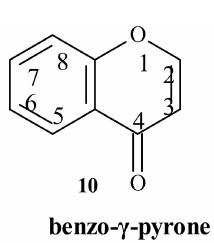
Figure 5. Structure of chromone.